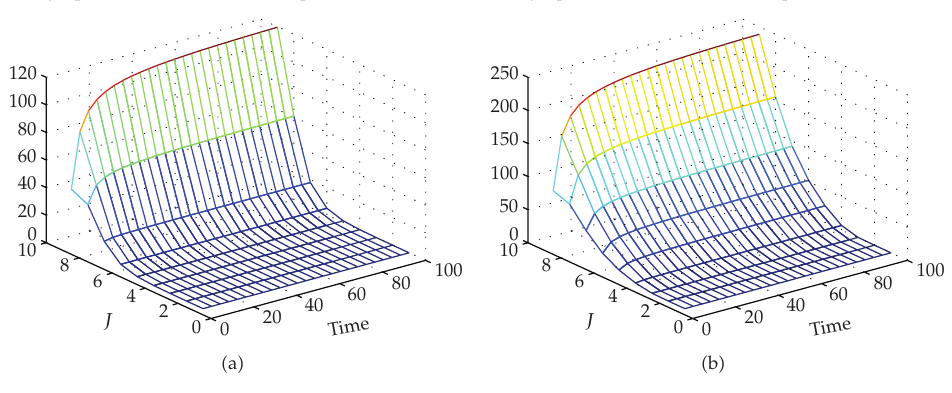
Figure 3: Mean of M (cid:3) t (cid:4) per unit time.